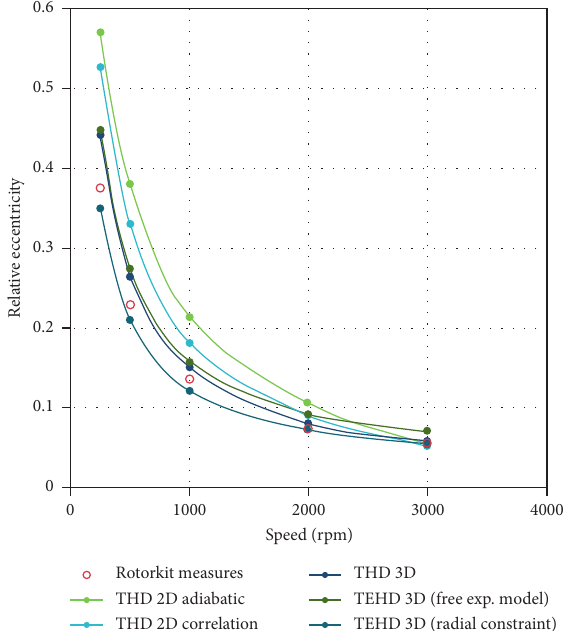
Figure 16: Relative eccentricity plot for the modified RK with respect to 3D numerical THD and TEHD simulation results in configuration 1.